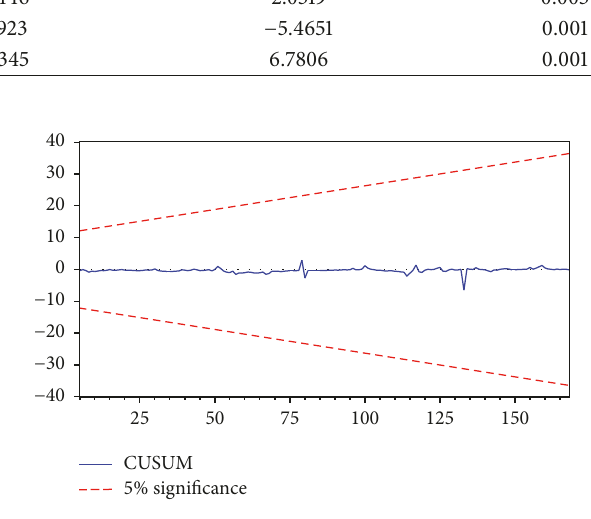
Figure 3: CUSUM test for